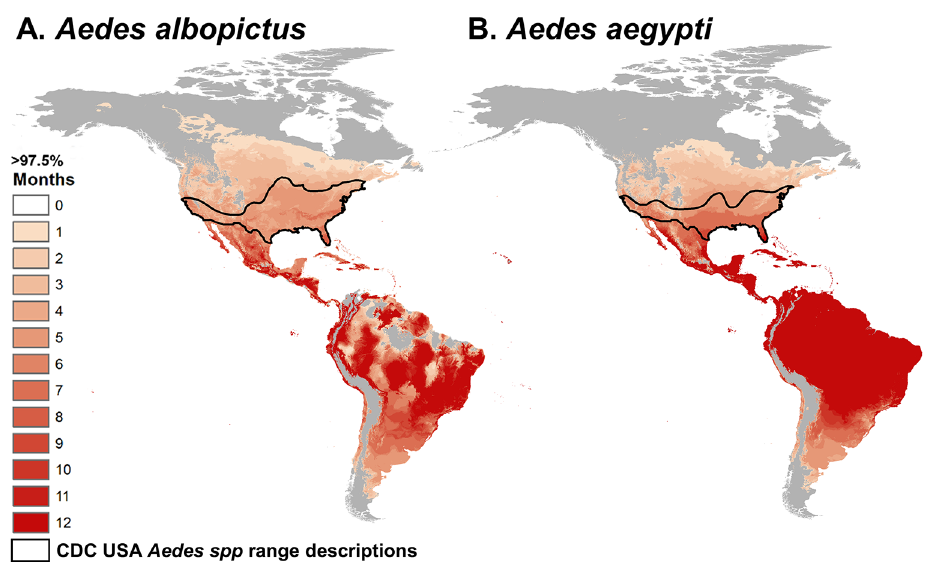
Fig 4. Map of predicted temperature suitability for virus transmission by Ae . albopictus and Ae . aegypti . Color indicatesthe consecutive months in which temperature is permissivefor transmission (predicted R 0 > 0) for Aedes spp. transmissionbasedon the minimum likely range ( > 97.5% posterior probabilitythat R 0 > 0). Black lines indicatethe CDC estimated range for the two Aedes spp. in the United States. Model suitability predictions combinetemperature mean and 8˚C daily variationand are informedby laboratorydata (Fig 1, Fig A in S1 Text) and validatedagainstfield data (Fig 3).